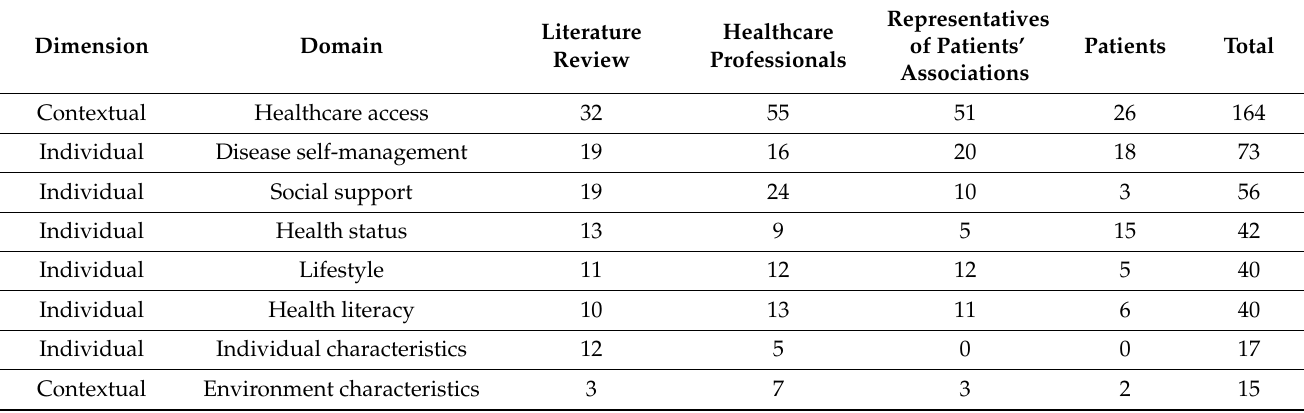
Table 3. Number of individual items identified in semi-structured interviews according to each domain of the determinants of ACSC